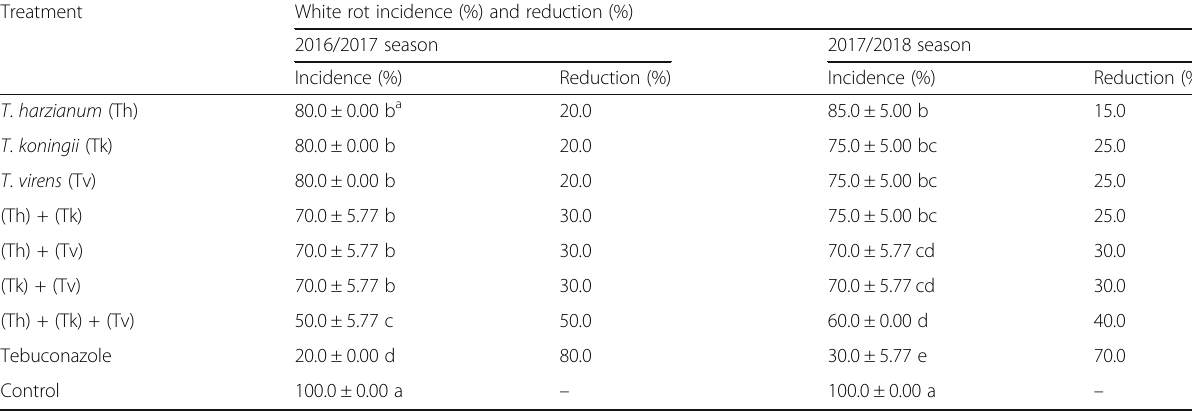
Table 3 Effects on white rot incidence (%) in garlic under greenhouse conditions Treatment White rot incidence (%) and reduction (%)